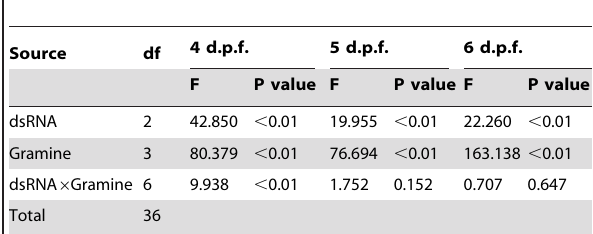
Table 1. Effect of brown planthopper ( BPH, Nilaparvata lugens ) nlgst1-1 dsRNA and gramine in artificial diets on BPH mortality.